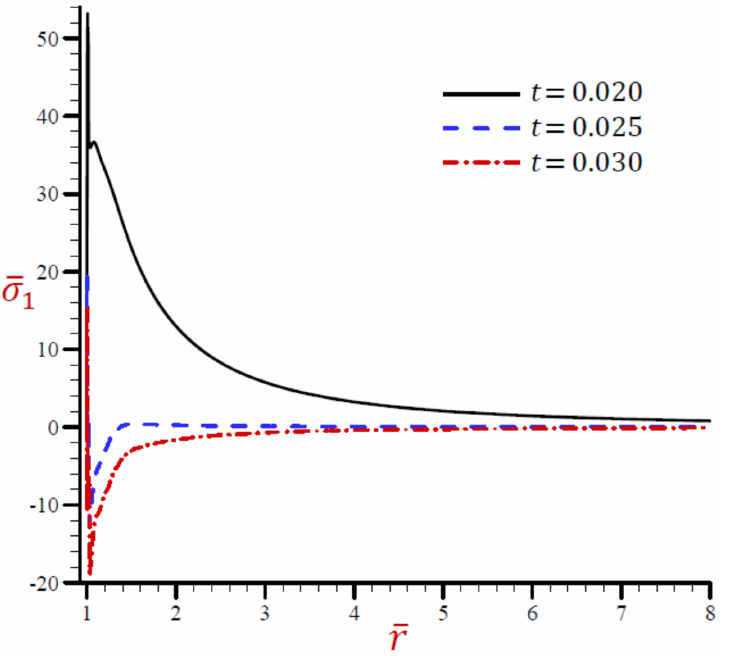
Figure 22. Effect of t on radial stress σ 1 across the radial direction of the cylindrical cavity utilizing the RDPL model.